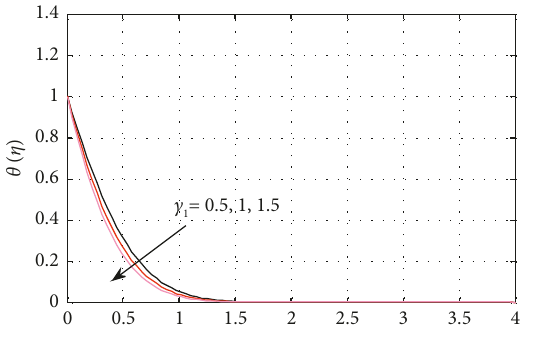
Figure 9: Impact of the reaction rate parameter on the concentration profile using A � 1 ,v � 0 . 4 ,Gr